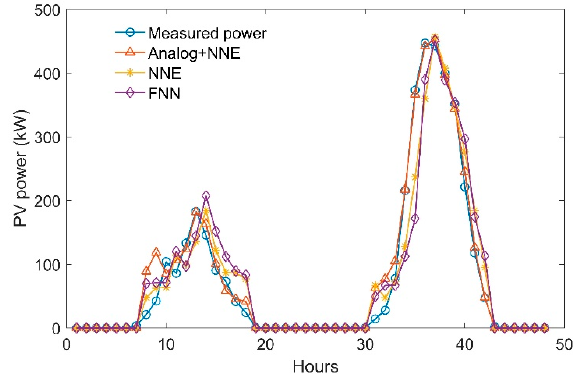
Figure 8. Forecast comparison of the methods from 14 January 2016 00:00 to 16 January 2016 00:00.